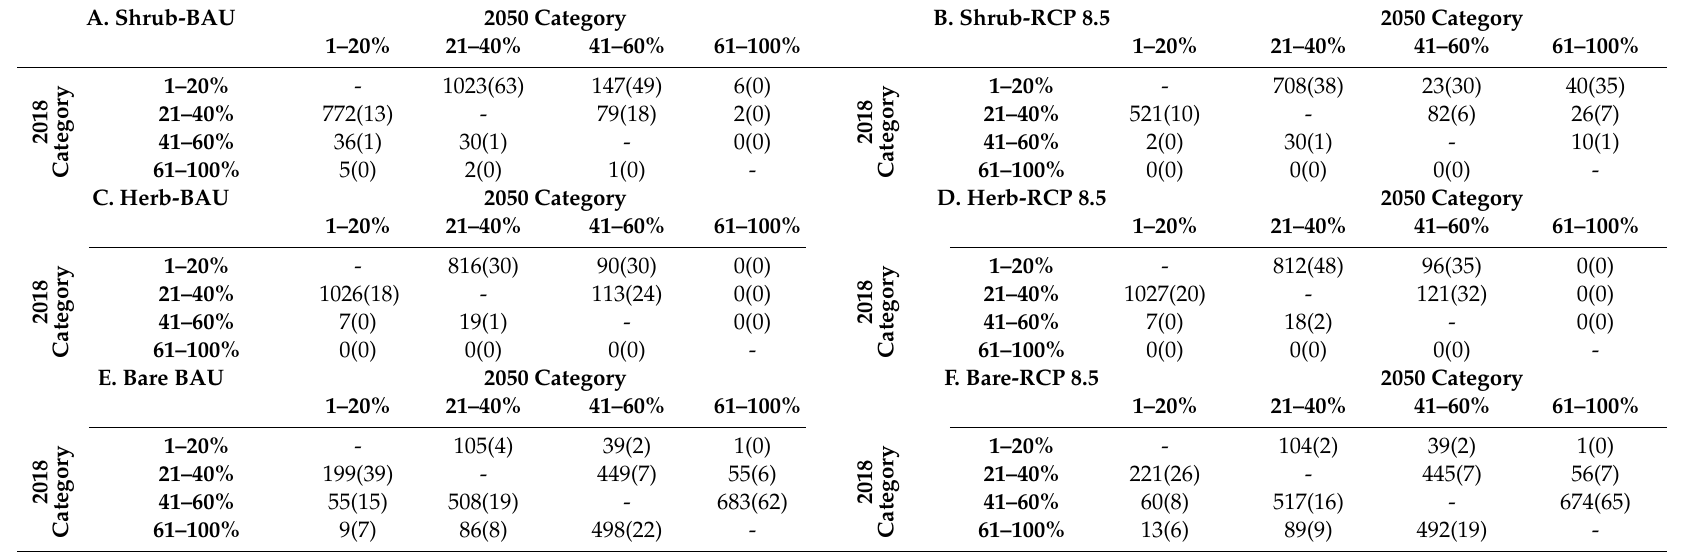
Table 3. Average transitions between categories for 2018–2050. Units are reported as square kilometers, with standard deviation across simulation marked with parentheses. The six models are labeled